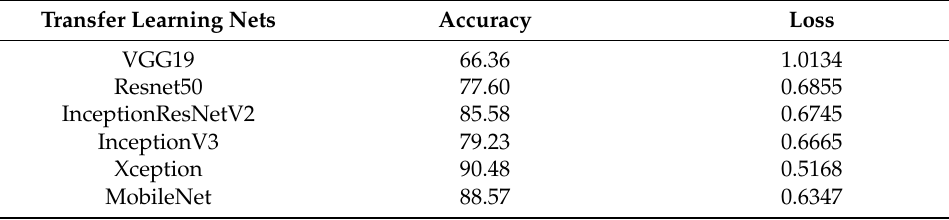
Table 6. Test accuracy and loss values of all learning nets used.